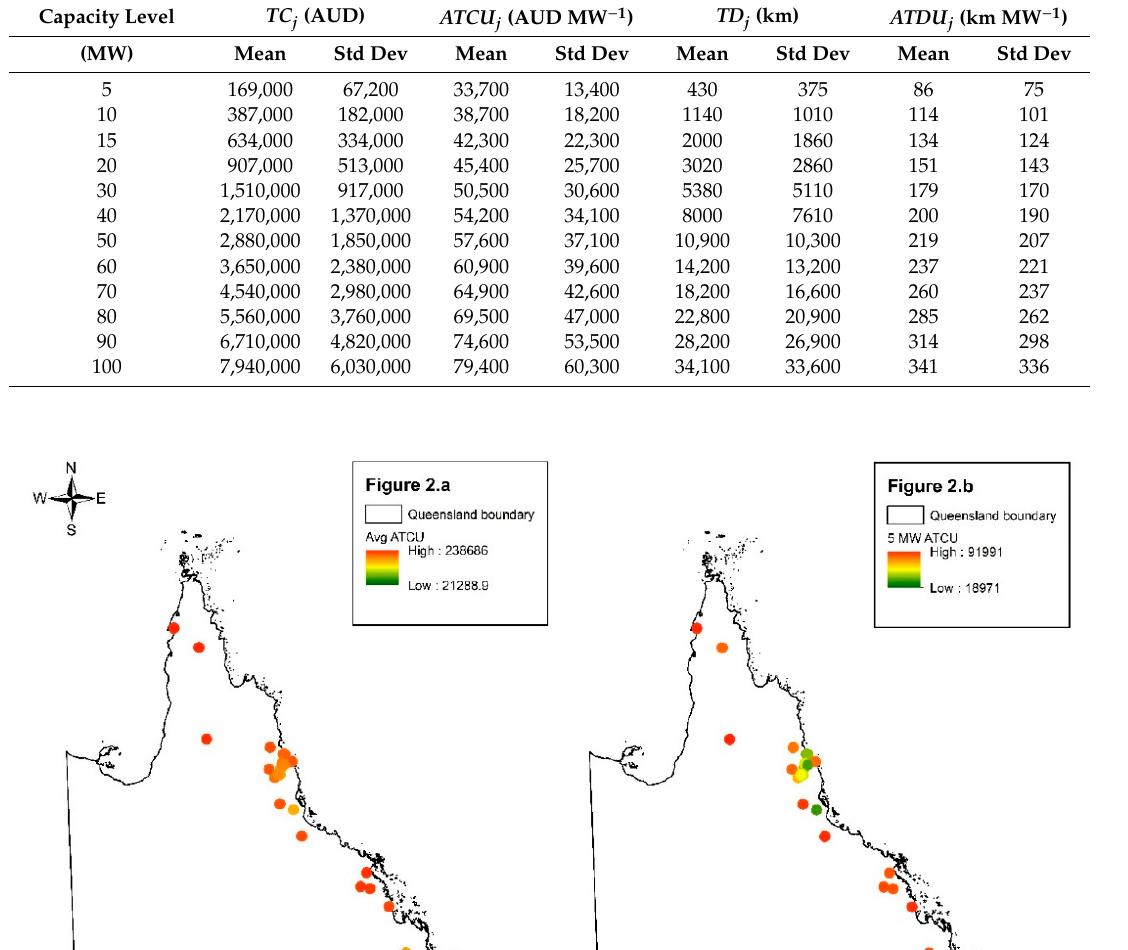
Table 1. Mean j th demand point ( TC j ), average transportation cost per unit of biomass (AUD MW − 1 ) for the j th demand point, ( ATCU j ), total transportation distance for the j th demand point ( TD j ), average transportation distance per unit of biomass (km MW − 1 ) for a given facility site ( ATDU j ) and SD values of 128 strategic locations for di ff erent capacities in Queensland.